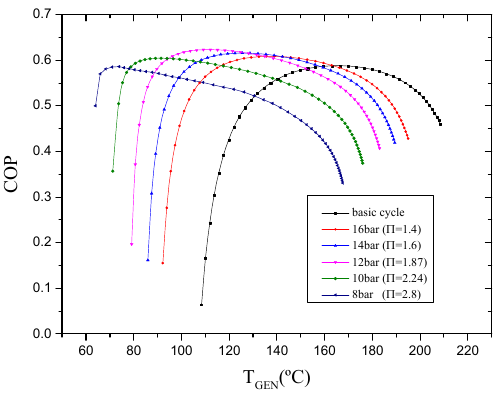
Figure 11. COP versus T GEN for configuration 2 at different intermediate pressures.